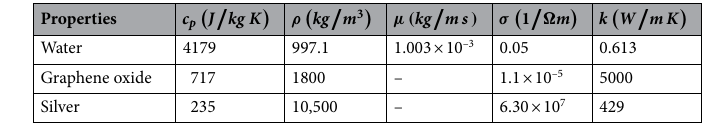
Table 2. Thermo-physical properties of nanoparticles and fluid phase 53,54